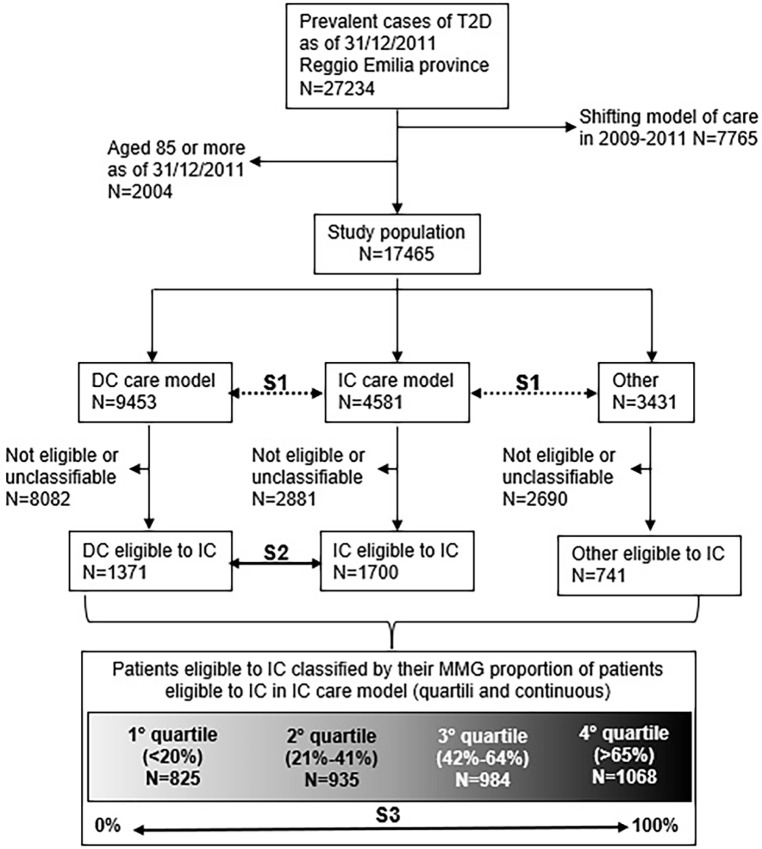
Flowchart showing the study population selection and the steps of analysis.S1 = step1 –mortality and hospitalisation rates by care model, no relative risk has been computed. S2 = step2 –to overcome selection bias, comparison was limited to patients eligible for the IC model, through mortality and hospitalisation risk rates, IC vs DC (Other-group vs DC analysis was omitted because the former was not a care model foreseen by the guideline). S3 = step3 –to overcome indication bias, we compared mortality and hospitalisation risk using the proportion of eligible patients actually in the IC model by GP (100% IC vs. 0% IC). DC = diabetes clinic; IC = integrated care.